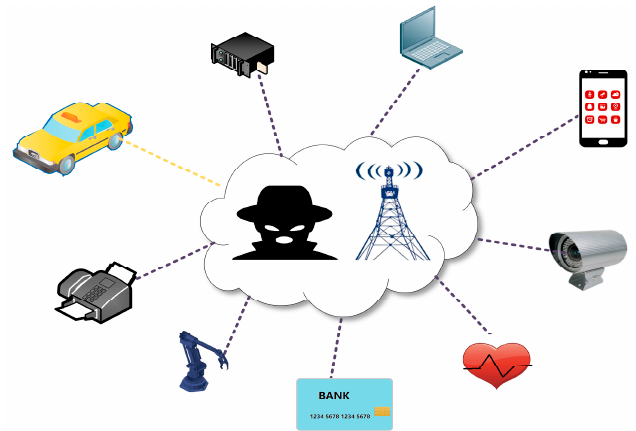
Figure 1. Attack scenario in the Internet of Things (IoT).